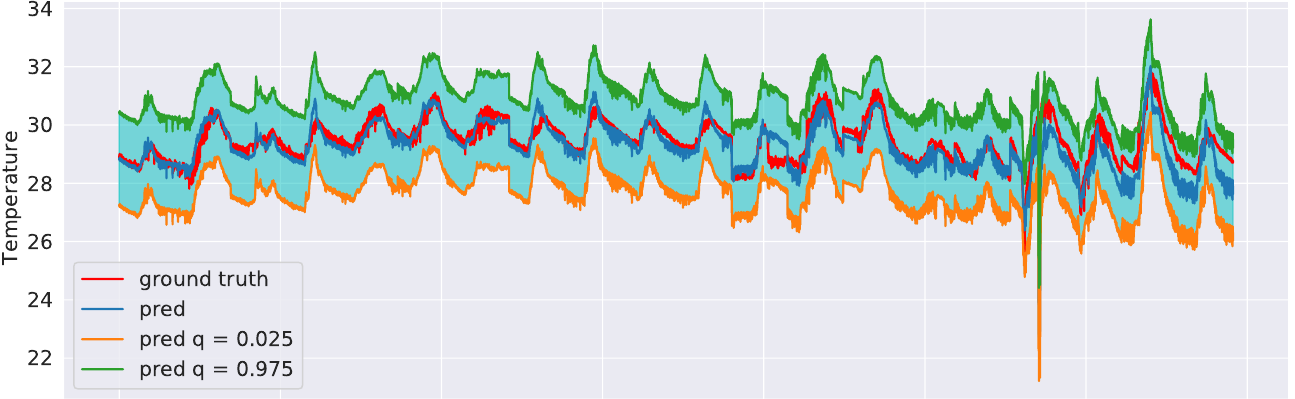
Figure 15. Linear regression prediction intervals related to sensor 3 test data with γ = 0.025 and γ = 0.975.